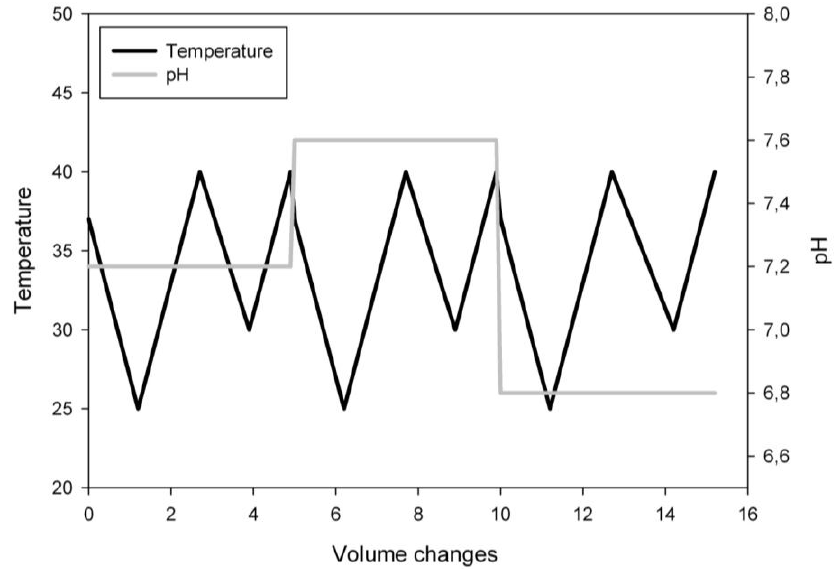
Figure 1. The concept of the study with temperature ramps and pH shifts with 1 L bioreactor working volume. On the x-axis, volume changes are depicted. The temperature range was chosen in accordance with meeting the temperature requirements of extreme halophiles and regarding the economical feasibility at the same time. The pH values were chosen to cover the 7.0–7.5 optimal range for growth from the